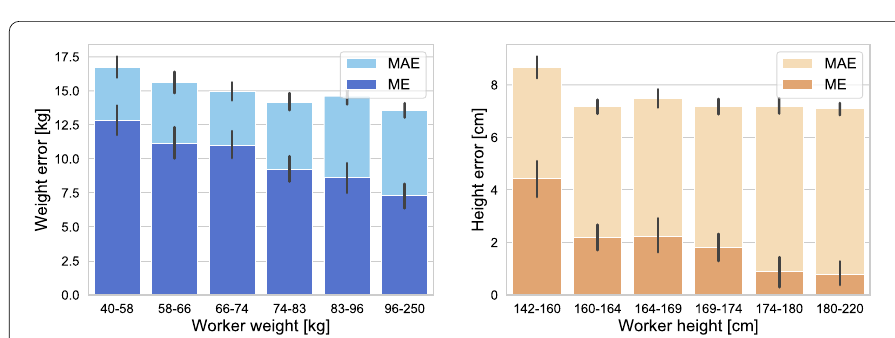
Figure 14 Dependence of weight/height mean error (ME) and mean absolute error (MAE) of guesses on worker’s weight/height